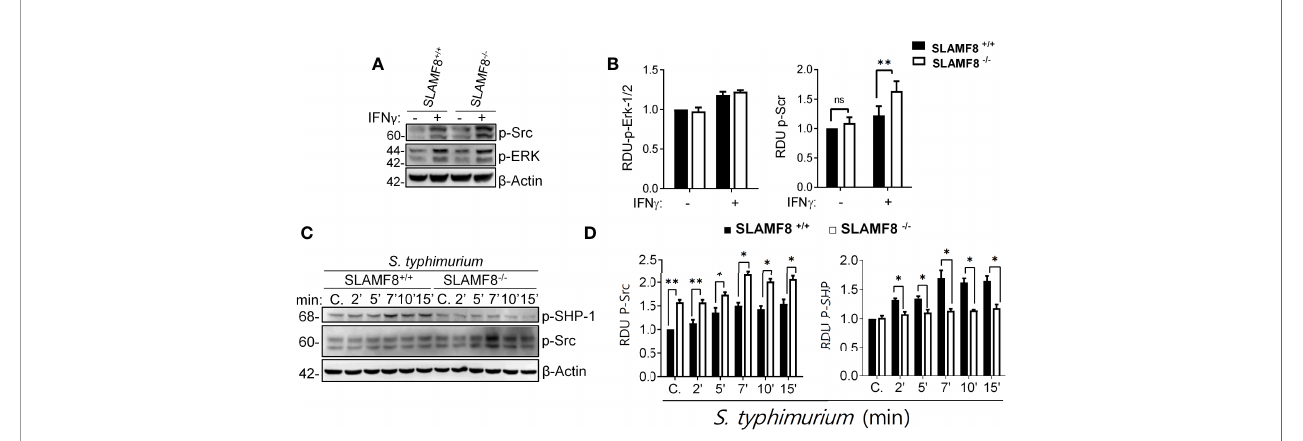
FIGURE 8 | SLAMF8 controls phosphorylation of Src and SHP-1 in pMø upon in vitro S. typhimurium infection. (A, C) Representative Western blots (left) of the indicated proteins in pMø, (A, B) treated with or without IFN g (100 U/ml) for 16 h, and (C, D) treated with IFN g with or without wt S. typhimurium (MOI 10) at different chase times. (B, D) Graphs represent the relative expression of the indicated proteins (right). Values indicate mean ± SEM of three independent experiments * p < 0.05, ** p < 0.01. C, Control; RDU, relative densitometry units; S, Serine; T,